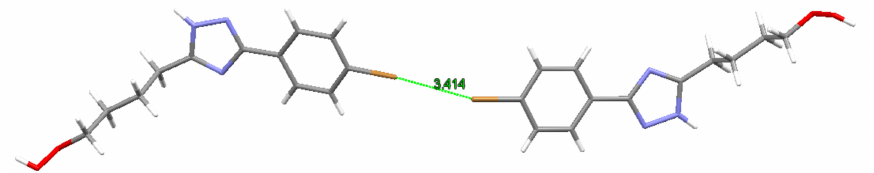
Figure 5. Intermolecular non-covalent interactions Br ··· Br (type I halogen ··· halogen contacts) in crystal of 3-(4-bromophenyl)-5-(4-peroxobutyl)-1,2,4-triazole. In [8], a series of halogenated aromatic dichlorodiazadienes were synthesized.